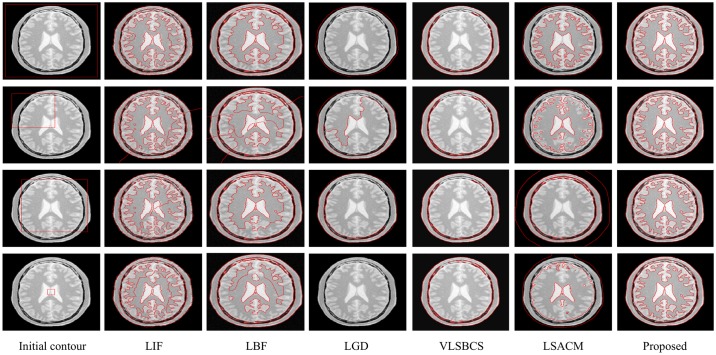
Effect of position of initial contour on the final segmentation results.